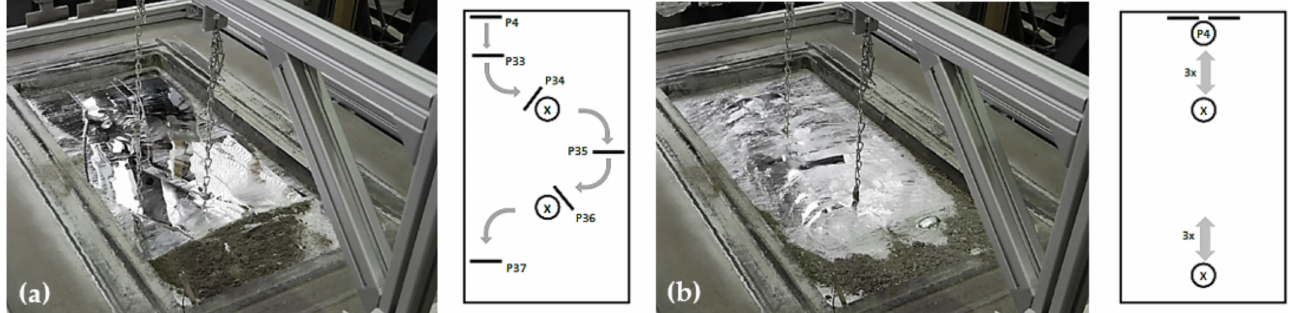
Figure 6. Task-related efficiency of the mechanical skimming system: ( a ) Two-step sinusoidal move- ment with a skimming rate of 0.05 m/s; ( b ) High-intensity pulse wave